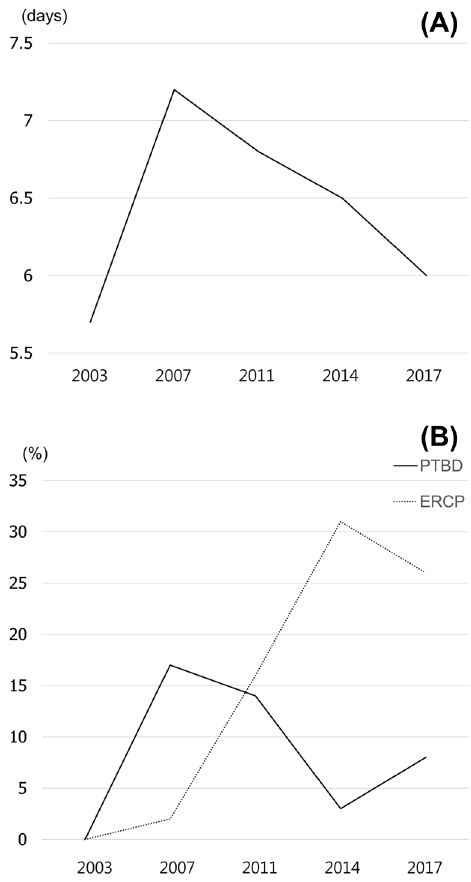
Figure 4. Duration of preoperative antibiotic therapy and frequency of PTBD and ERCP over time. ( A ) The duration of preoperative antibiotic therapy at initial period (2003–2005) was 5.7 ± 3.2, but increased to 7.2 ± 5.2 days between 2006 and 2008 and consistently decreased to 5.9 ± 6.0 days between 2015 and 2017, without statistical significance ( P = 0.678). ( B ) The frequency of PTBD had a significant decreasing trend over time ( P = 0.037), from 9 out of 53 (17.0%) between 2005 and 2007 to 2 out of 59 (3.4%) between 2012 and 2014, but increased in the recent period (11 of 131, 8.4%). Otherwise, ECRP had significant increasing trend over time ( P = 0.000) from 1 out of 53 (1.9%) between 2005 and 2007 to 18 out of 59 (30.5%) between 2012 and 2014, but decreased in the recent period (34 of 131, 26.0%).